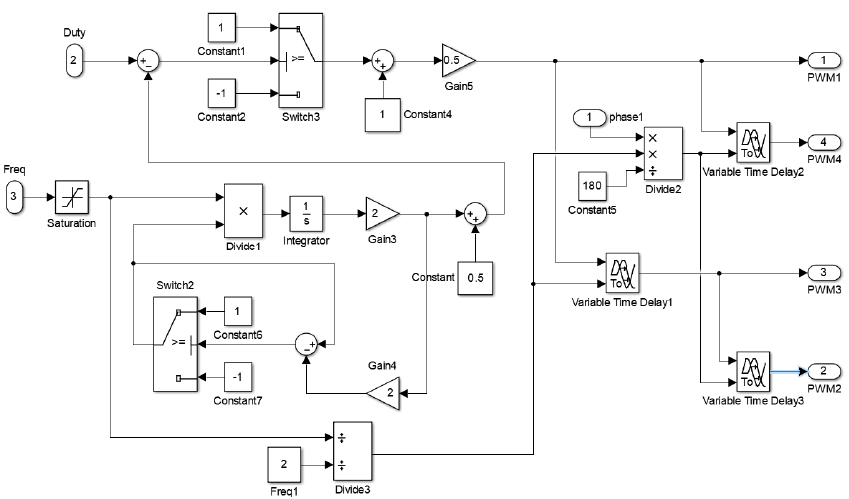
Figure 14. Internal structure of the driver wave generator.